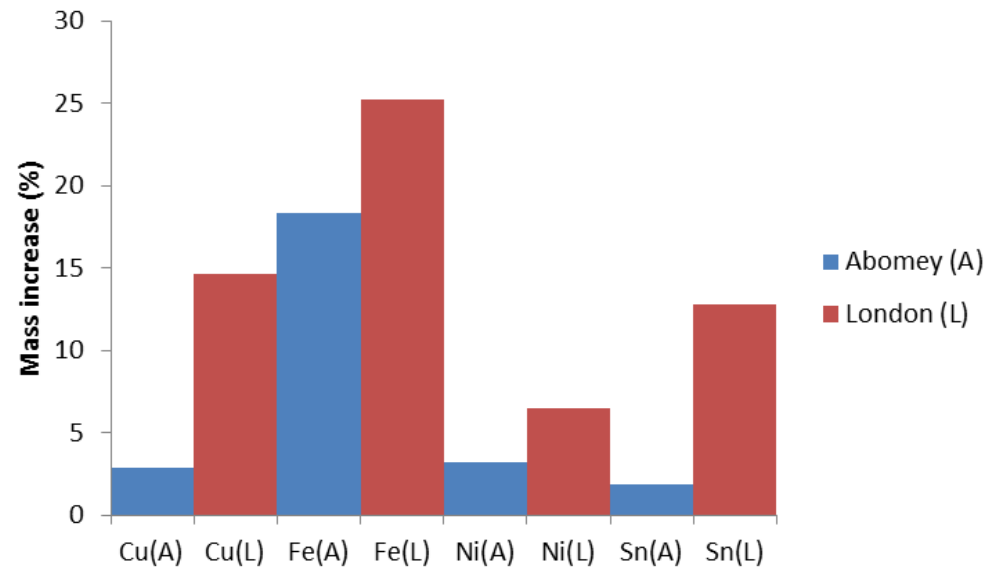
Figure 7. Percentage of mass increase measured by 50 nm PQC sensors in London (L) and Abomey (A) over 140 days between November 2012 and April 2013.